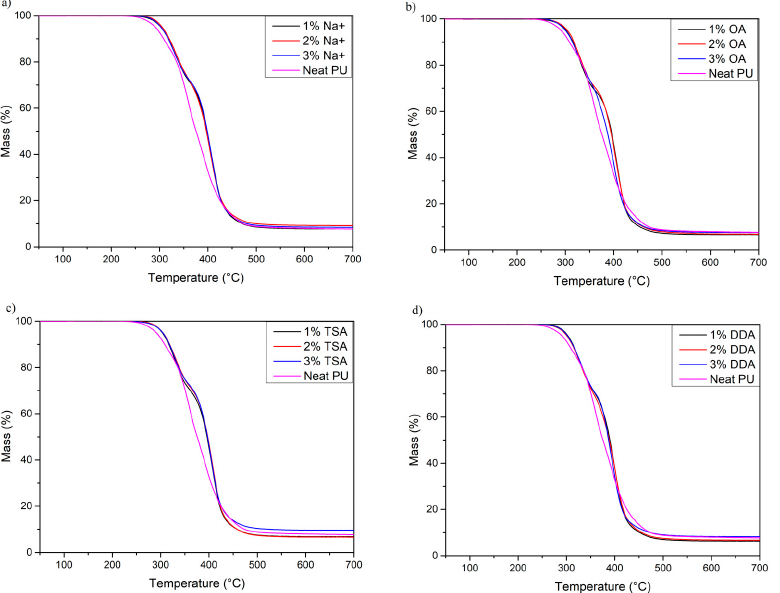
Figure 2. Thermogravimetric (TG) curves of neat PU and manufactured nanocomposites. ( a ) Na+ samples; ( b ) OA samples; ( c ) TSA samples; ( d ) DDA samples.